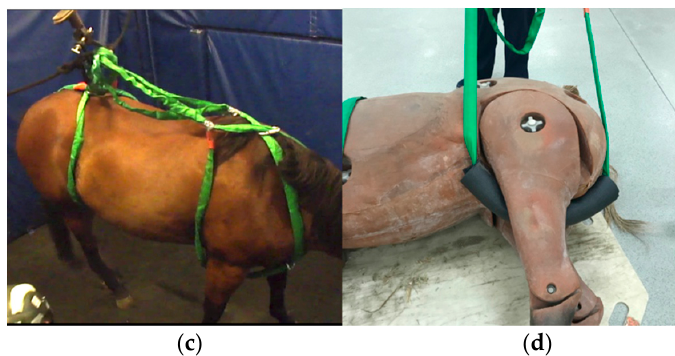
Figure 1. Placement of the Loop Vertical Lift System. ( a ). Placement of loops on the cranial aspect of the horse’s body. Carabiners are used to hold the loops in place at the sternum and withers. ( b ). Placement of loops on the caudal aspect of the horse’s body. ( c ). Full Loop Vertical Lift System attached to the anchor shackle and electric winch. ( d ) Foam cushion on the loop between the hind limbs. Duct tape is used to keep loops properly placed during application of the Loop Vertical Lift System.